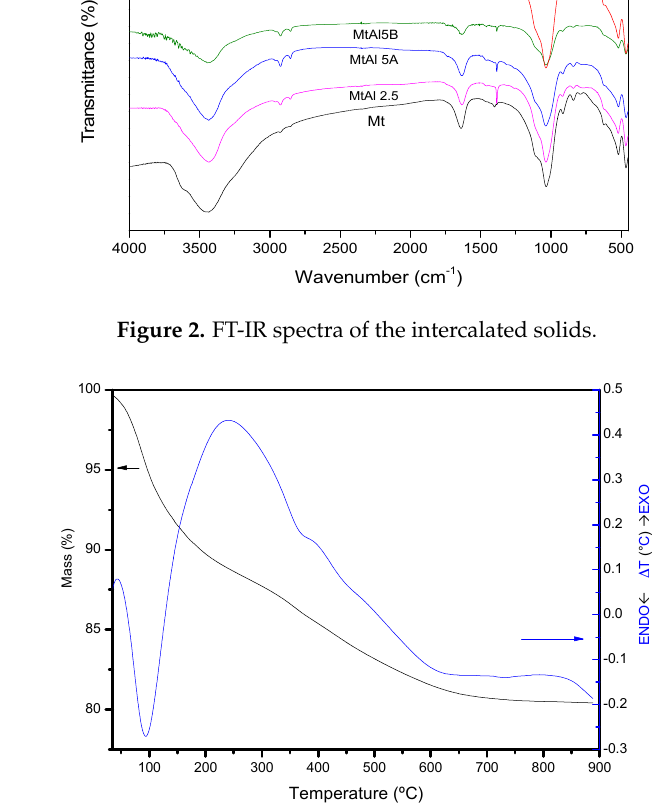
Figure 3. Thermal curves, TG, and DTA of MtAl10 solid.